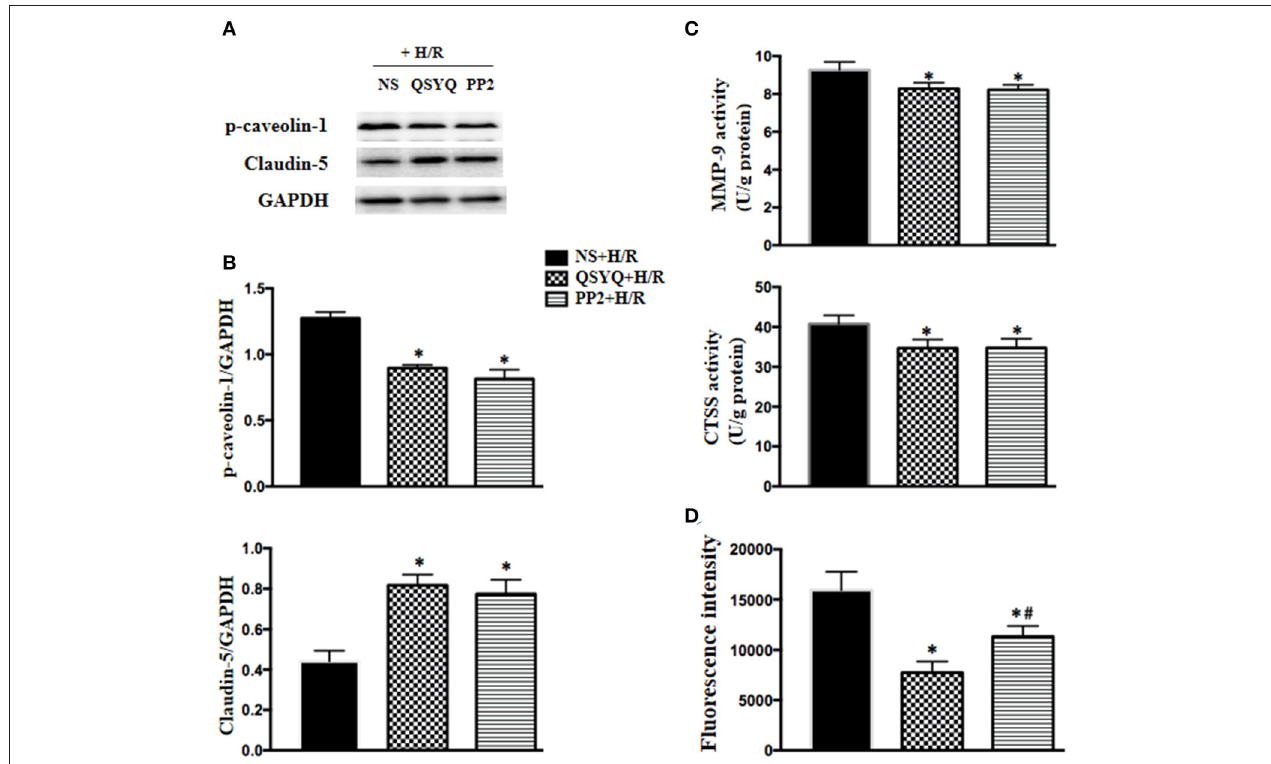
FIGURE 7 | Effect of PP2 on the expression of claudin-5 and p-caveolin-1, the activity of MMP-9 and CTSS, and hyperpermeability of HCMECs monolayer exposed to H/R. (A) Representative western blot bands (A) and relative densitometric values (B) of p-caveolin-1 and claudin-5 in HCMECs in different groups. GAPDH was used as a loading control. (C) Quantitative measurement of MMP-9 and CTSS activity by ELISA in HCMECs. (D) Effect of QSYQ on hyperpermeability of HCMEC monolayer induced by H/R. The permeability was expressed as the optical density of FITC-dextran at 492nm in the lower chamber. Data are expressed as means